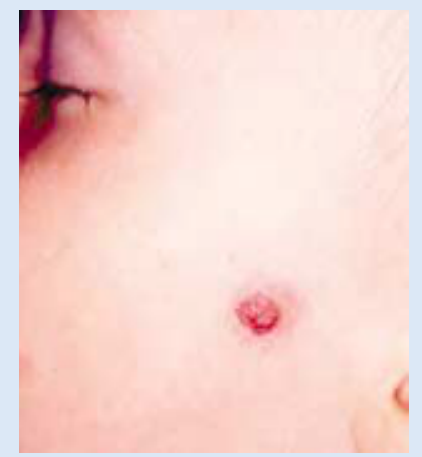
Fig. 1a. Small cutaneous haemangioma on the cheek of an infant.